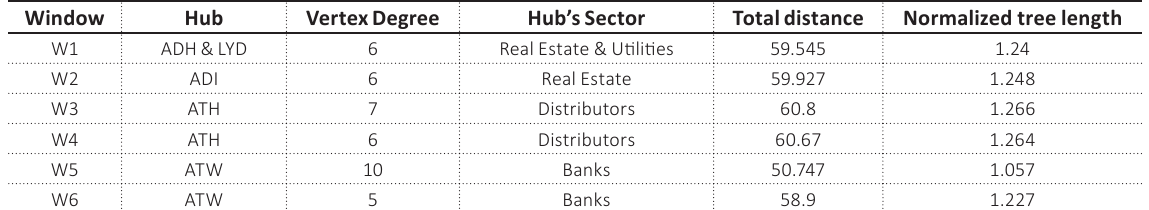
Table 4. Topological characteristics of the MST corresponding to the six equal windows